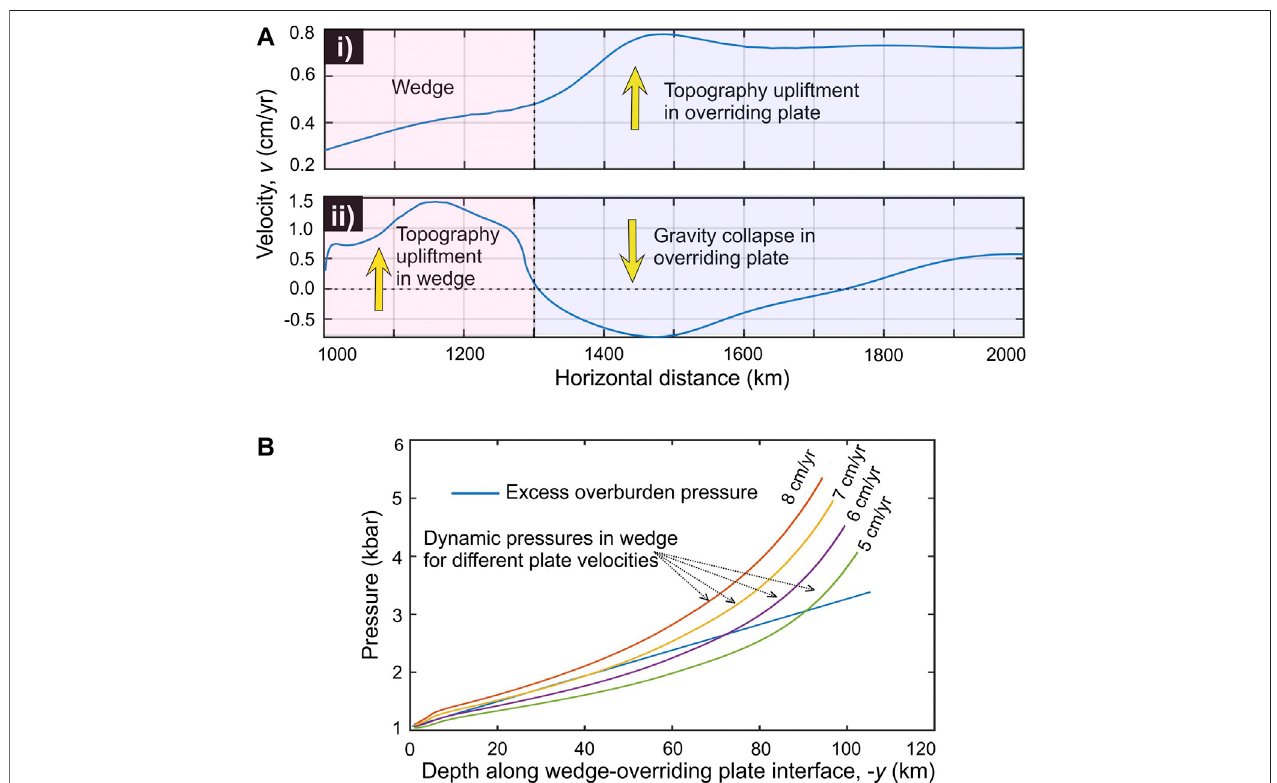
FIGURE6|(A) Plotsoftheverticalvelocitycomponentmeasuredonthetopmodelsurface,showingthetopographyevolutioninthemodelsfori) u s (cid:1) 8 cm/yrand ii) u s (cid:1) 5 cm/yr. (B) Calculated dynamic pressure ( P Dy ) in the model orogenic wedge for varying subduction velocity ( u s ). Note, at u s (cid:1) 6 cm/yr, P Dy drops below the overburdenpressure( P Ob )withinasmallpartofthewedge.But,for u s (cid:1) 5 cm/yr, P Dy becomessigni fi cantlylessthan P Ob overalargepartofthewedge,resultinginafully developed large-scale extrusion zone within the wedge.